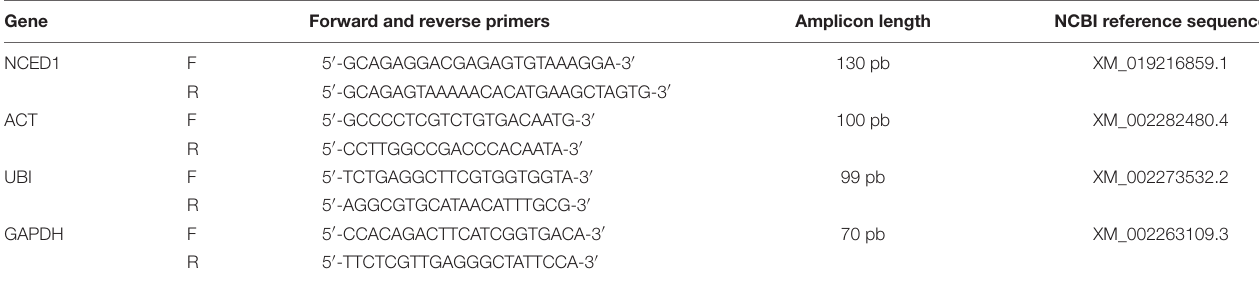
TABLE 1 | Transcriptomic details of primers for the targeted and endogenous control genes. Gene Forward and reverse